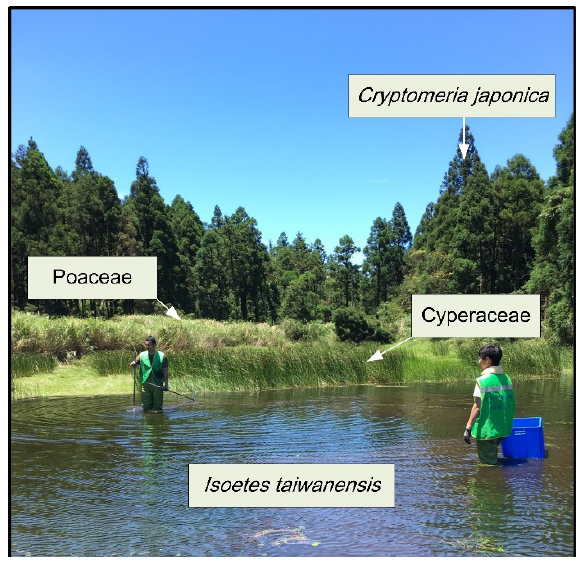
Figure 3. Dream Lake wetland in July 2017. The exotic conifer species Cryptomeria japonica is present along the shores of the wetland. The vegetation zones characterized by Poaceae, Cyperaceae, and Isoetes taiwanensis can be seen.